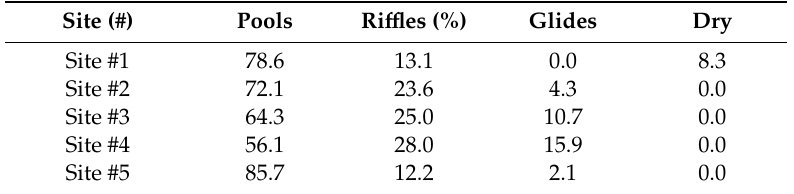
Table 7. Channel unit frequency measured at survey sites (n = 561) and averaged within five nested sub-basins located in Hinkson Creek Watershed, Missouri,